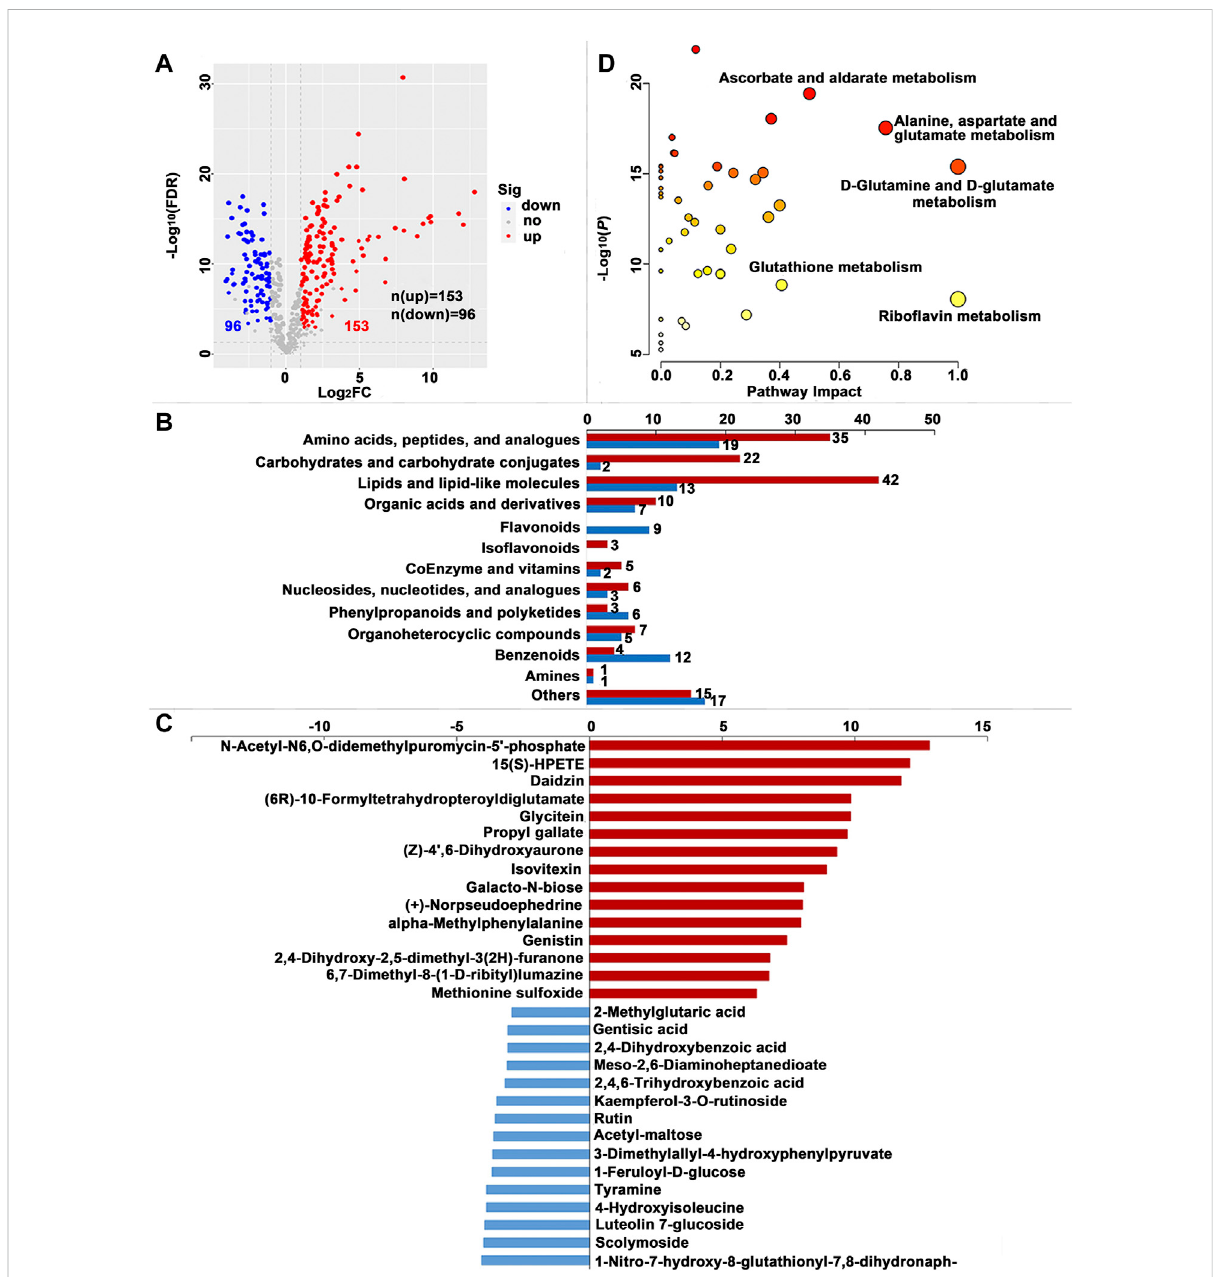
Signi fi cantly different metabolites (SDMs) and enriched pathways relating to different diets in the hemolymph (HL). (A) Volcano plots of metabolitesfortheformulafeed(FF)andthemulberryleaves(ML)silkwormsintheHL.Thereddotrepresentsthemetaboliteissigni fi cantlyhigherin the FF silkworms, and the blue dot indicates a higher abundant metabolite in the ML silkworms. The dot size represents the VIP value. (B) SDMs classi fi cation and variation between the FF and ML group. The blue and red bar indicate the number of downregulated and upregulated metabolites in the HL of the FF group, respectively. (C) The top 15 upregulated SDMs and downregulated SDMs in the HL of the FF silkworms. (D) Metabolic pathways enriched by the SDMs between the FF and ML groups in the